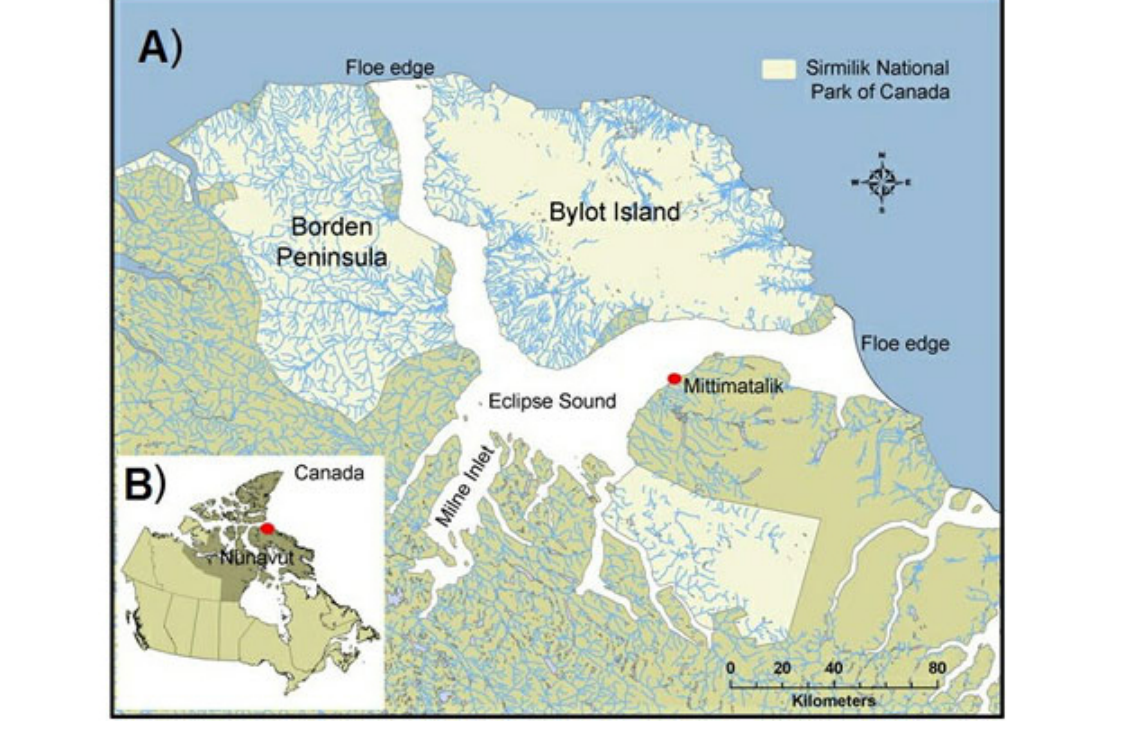
Fig. 1 . Study area. (A) Close-up of the study area showing north Baffin Island and Bylot Island, Nunavut, Canada. The community of Mittimatalik is the closest and largest settlement located near the Sirmilik National Park of Canada (lighter beige). (B) Location of the Nunavut territory (darker beige), in which the red circle indicates the general study area